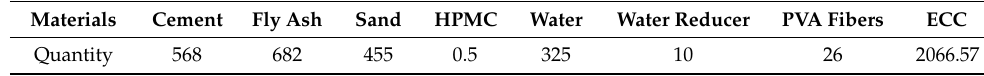
Table 1. Mix proportion of ECC (kg/m 3 ).